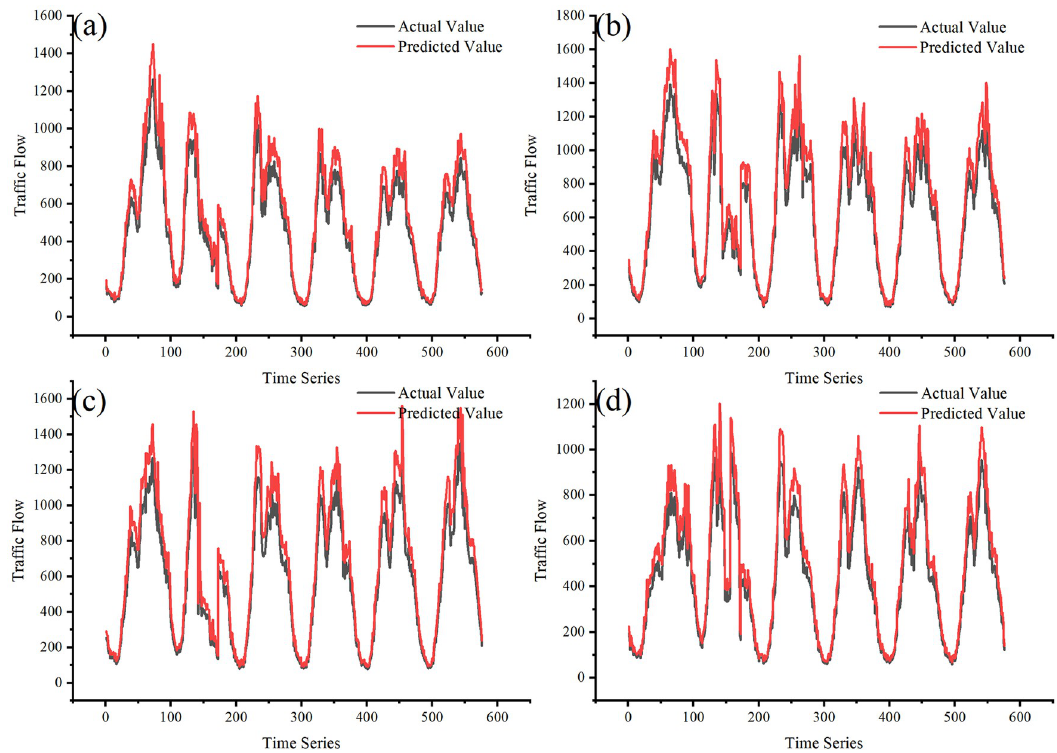
Fig 9. Comparison of the prediction performance for different models. (a) Xinglin Interchange Section; (b) Xiang’an Interchange Section; (c) Chidian Interchange Section; (d) Putian Interchange Section.